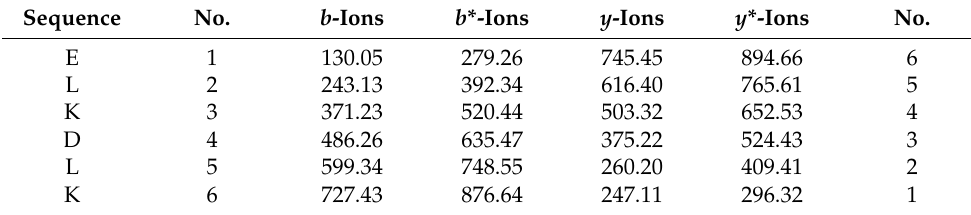
8080/proteomicsToolkit/FragIonServlet.html; accessed on 20 September 2021). As post-